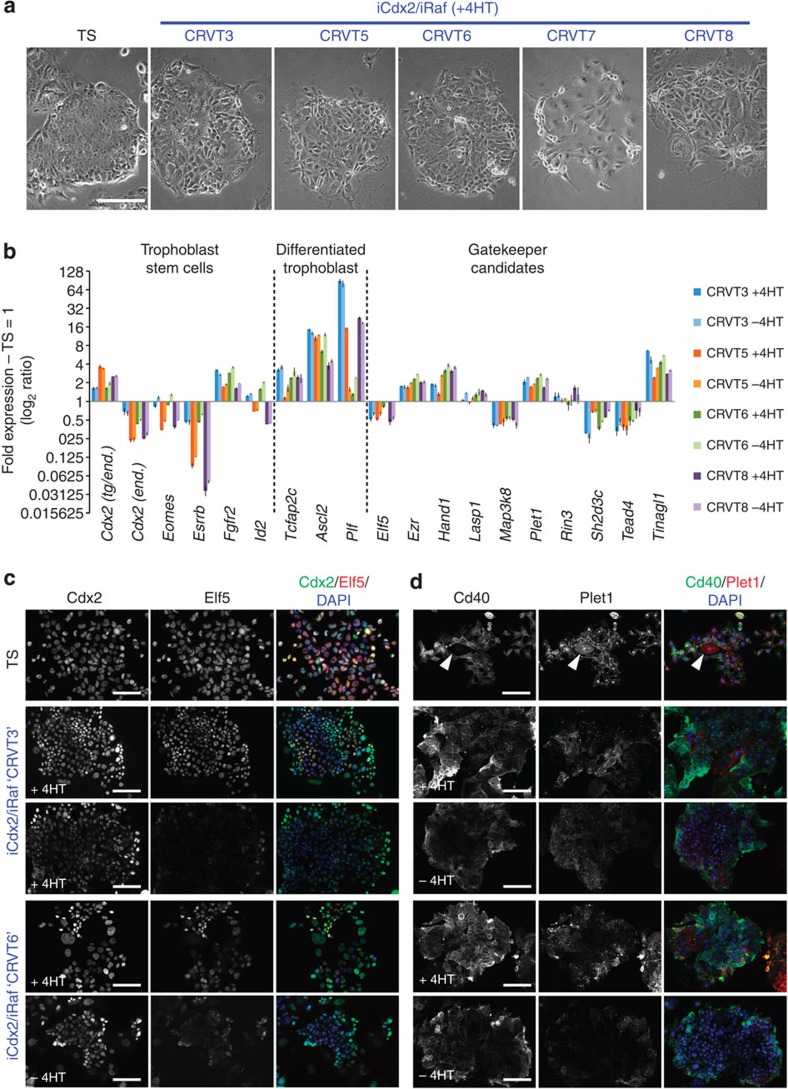
Selection strategy by epithelial morphology in the most efficient iCdx2/iRaf reprogramming model.(a) Phase contrast images of TSL clones selected on the basis of colony shape and epithelial morphology. After an initial 5-day reprogramming on MEFs, cells were passaged for 5 weeks on tissue culture plastic in TS cell conditions in the presence of 4HT, during which time colonies were picked and expanded. Clone heterogeneity is observed, with clones CRVT3 and CRVT6 exhibiting the most genuinely TS-like epithelial colony shape. Scale bar: 200 μm. (b) Expression analysis of a cohort of trophoblast stem cell and differentiation-associated genes, as well as the identified gatekeeper loci, in selected clones. After growing/expanding colonies in the presence of 4HT for 5 weeks, cells were seeded ±4HT and RNA harvested after 2 days. Tight epithelial morphology in clones CRVT3 and CRVT6 correlates with TS-like Eomes expression levels. Overall, however, differentiation-associated markers are vastly upregulated, and gatekeeper gene expression remains unbalanced. Lack of transcriptional activation of Elf5, Map3k8, Sh2d3c and Tead4 is evident. Values are of three replicates and expressed as mean±s.e.m. (c) Immunostaining on these clones for Cdx2 and Elf5. Frequent lack of activation or re-silencing of Elf5, correlated with a more pronounced tendency to differentiate, is observed. (d) Immunostaining for TS cell surface markers Cd40 and Plet1. Plet1 is a GPI-anchored membrane-associated protein in TS cells, but is redistributed towards a cytoplasmic localization in differentiating trophoblast cells (arrowhead). Despite the TS-like colony shape, reprogrammed cell clones are extremely variable for Cd40 and largely fail to express Plet1 on their cell surface in a TS-like pattern and intensity. All photographs in c,d were taken at precisely the same exposure settings. Scale bars: 100 μm.